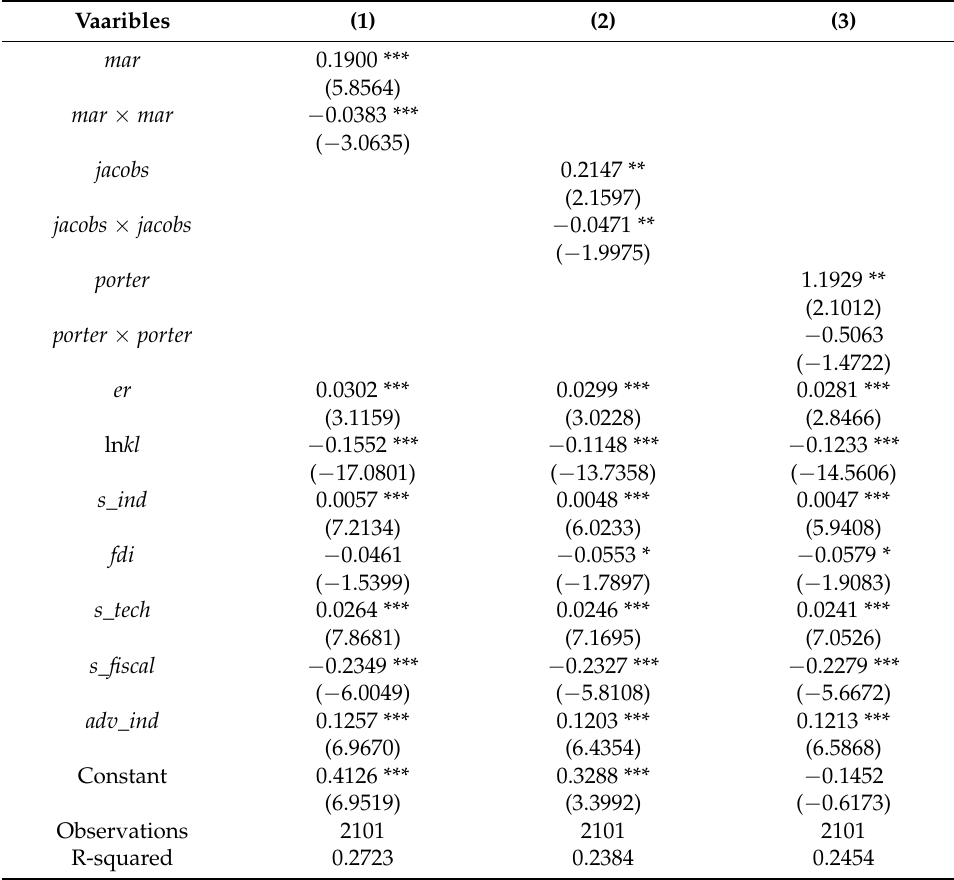
Table 8. Robustness check: eco-efficiency alternative